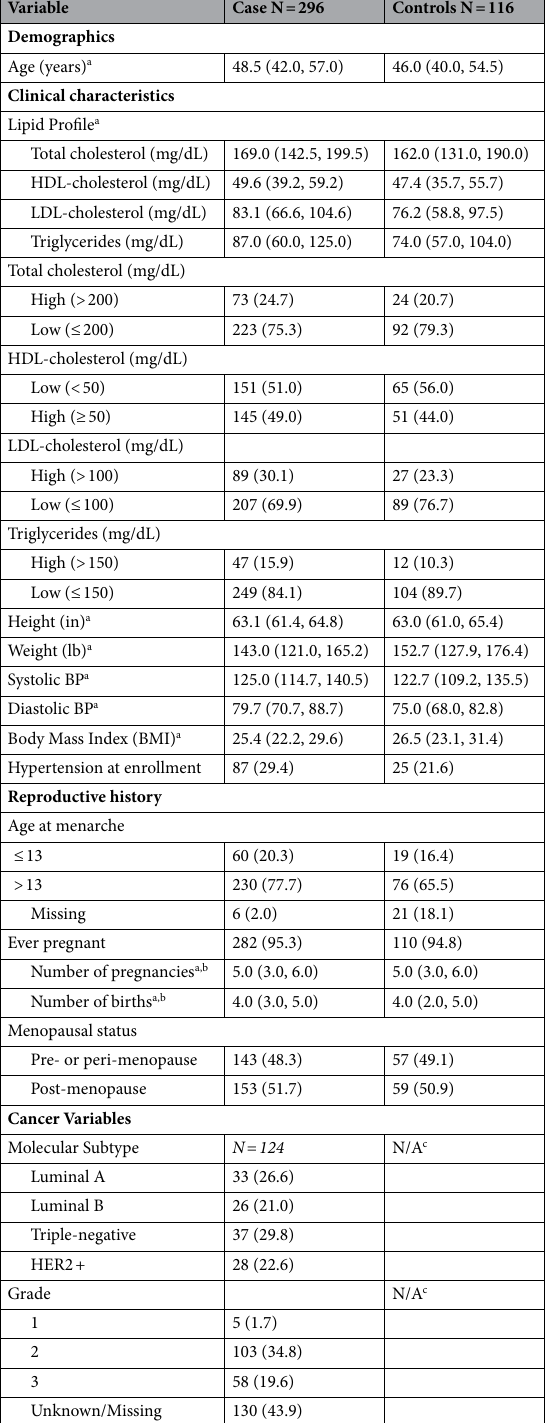
Table 1. Clinical and reproductive characteristics of MEND breast cancer cases and controls. a Median (Q1, Q3). b Among those who were ever pregnant. c Cancer variables are not applicable to control